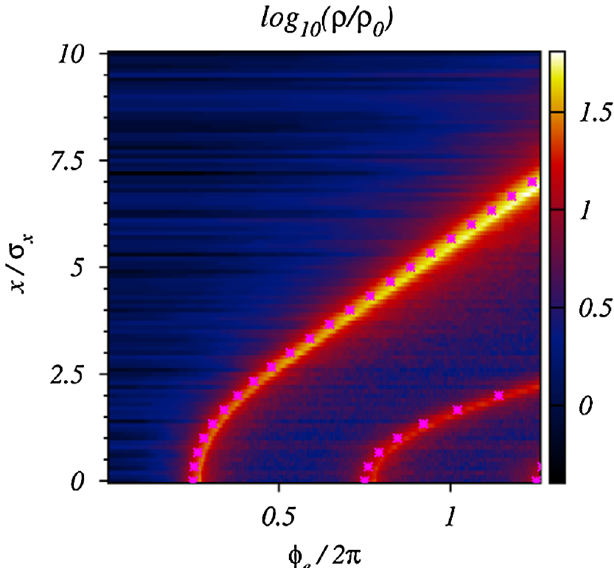
FIG. 6. (Color) Reduction of the EC stripe for shortening the bunch length to (cid:2) z ¼ 0 : 0432 m . The number of stripes is correctly predicted by Eq.